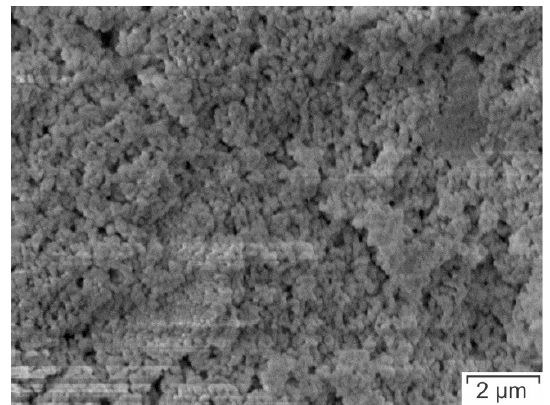
Figure 1. SEM of the zirconia powder partially stabilized with yttria.